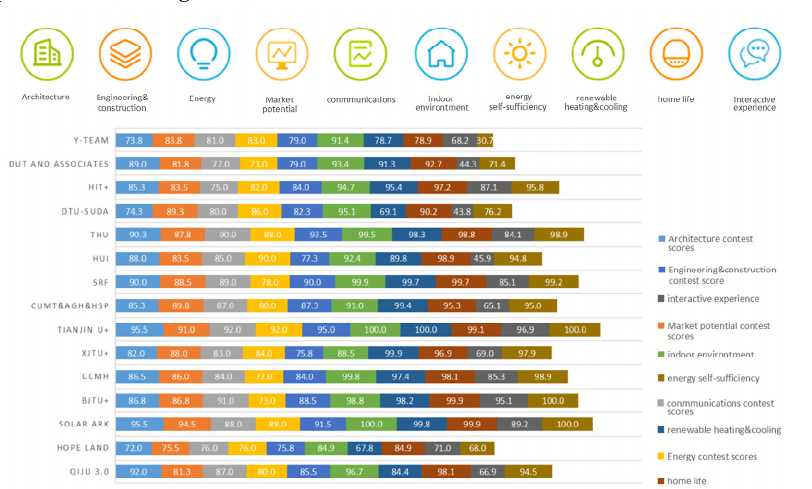
Figure 2. Ten evaluation criteria and their scoring proportions.